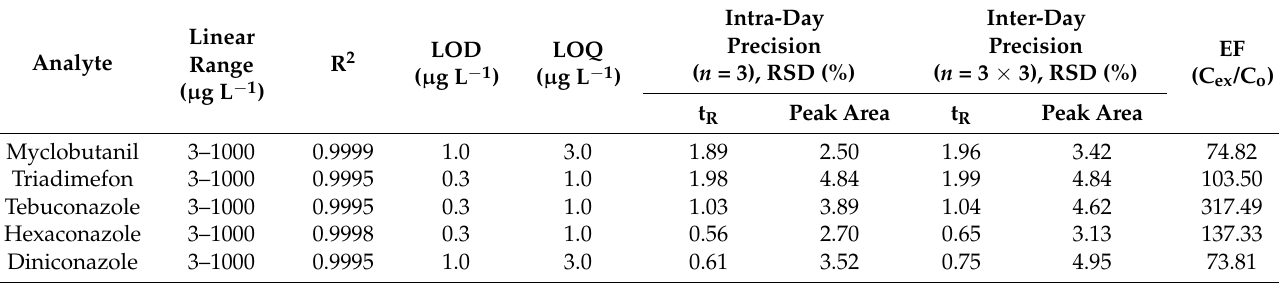
Table 1. Analytical performances of the present